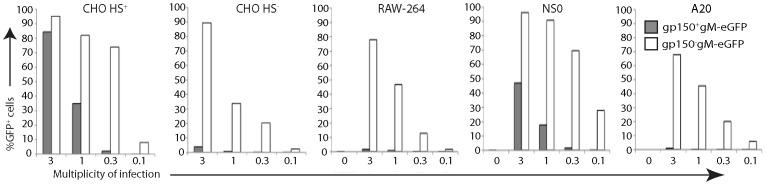
Binding of different cell types by gp150+ and gp150− virions.Cells were exposed to gp150+ and gp150− versions of MuHV-4 with eGFP linked to the cytoplasmic tail of gM (gM-eGFP) (4 h, 37°C), then washed ×3 in PBS, and 20,000 cells assayed for virion binding/uptake by flow cytometry of eGFP fluorescence. Equivalent total protein content of the gp150+ and gp150− virus stocks was confirmed by Coomassie staining, and equivalent eGFP content was confirmed by immunoblotting (Fig. S3). Gp150 disruption significantly increased virus binding to all cell types (p<10−5 by Chi-squared test, comparing the relative proportions of eGFP+ and eGFP− cells over at least 3 virus dilutions). Similar data were obtained in a repeat experiment.